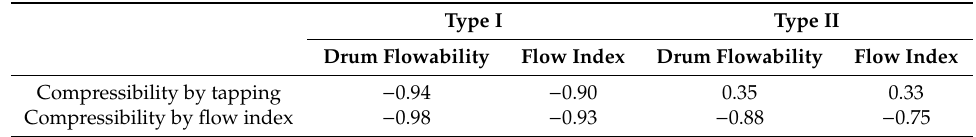
Table 5. Correlation (Pearson’s r) between compressibility and flowability measurements for Type I and II powders ( n = 6 for each